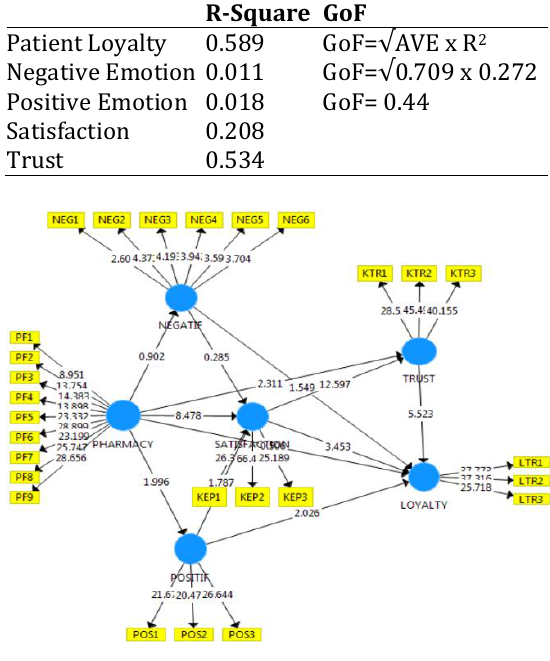
Figure 1. Model Structural of Patient